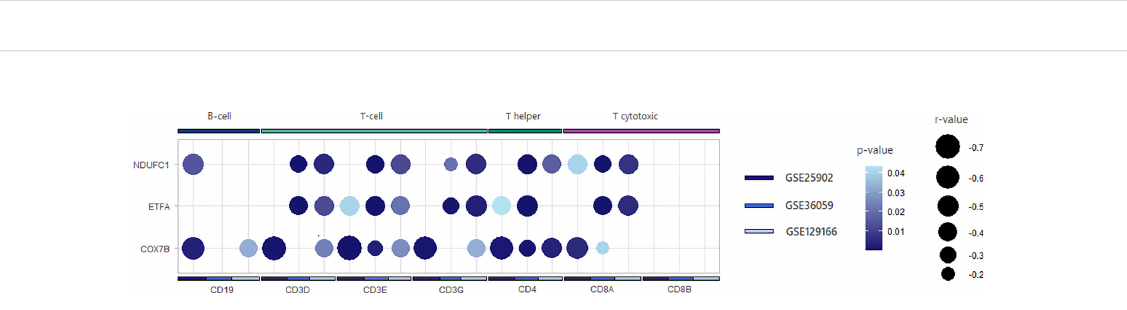
FIGURE 5 Correlation plot between oxidative phosphorylation genes and lymphocyte receptors genes. Summarized plot representing correlations ’ magnitude and signi fi cance. Dot size is inversely proportional to r coef fi cient. Dark blue color indicates more signi fi cant correlations, while light tones indicate less signi fi cant p-values. Correlations that did not reach p-value <0.05 were suppressed from the